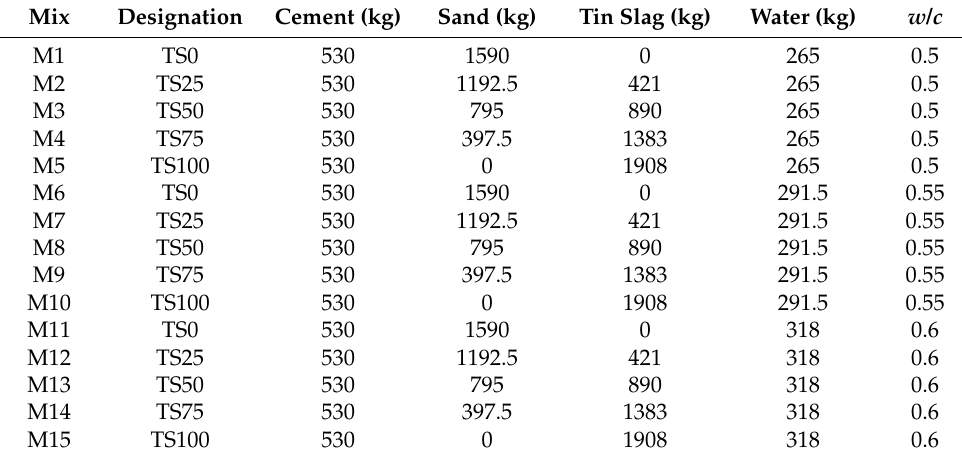
Table 5. The mix proportions of constituents for 1 m 3 of